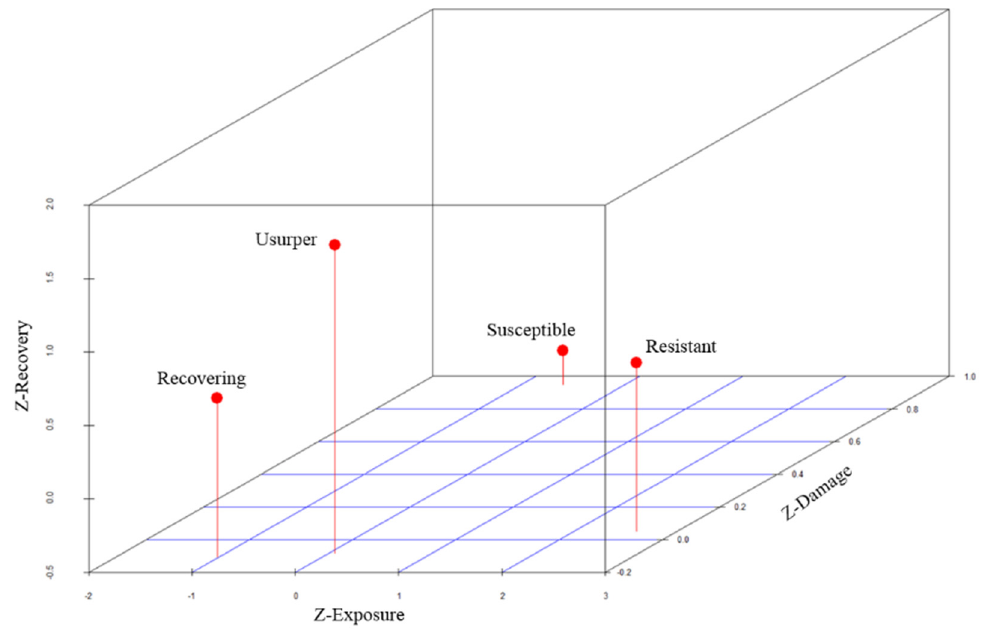
Figure 6. Three-dimensional plot of behaviors of the 4 community resilience states. Table 3. Comparison between the two classifications